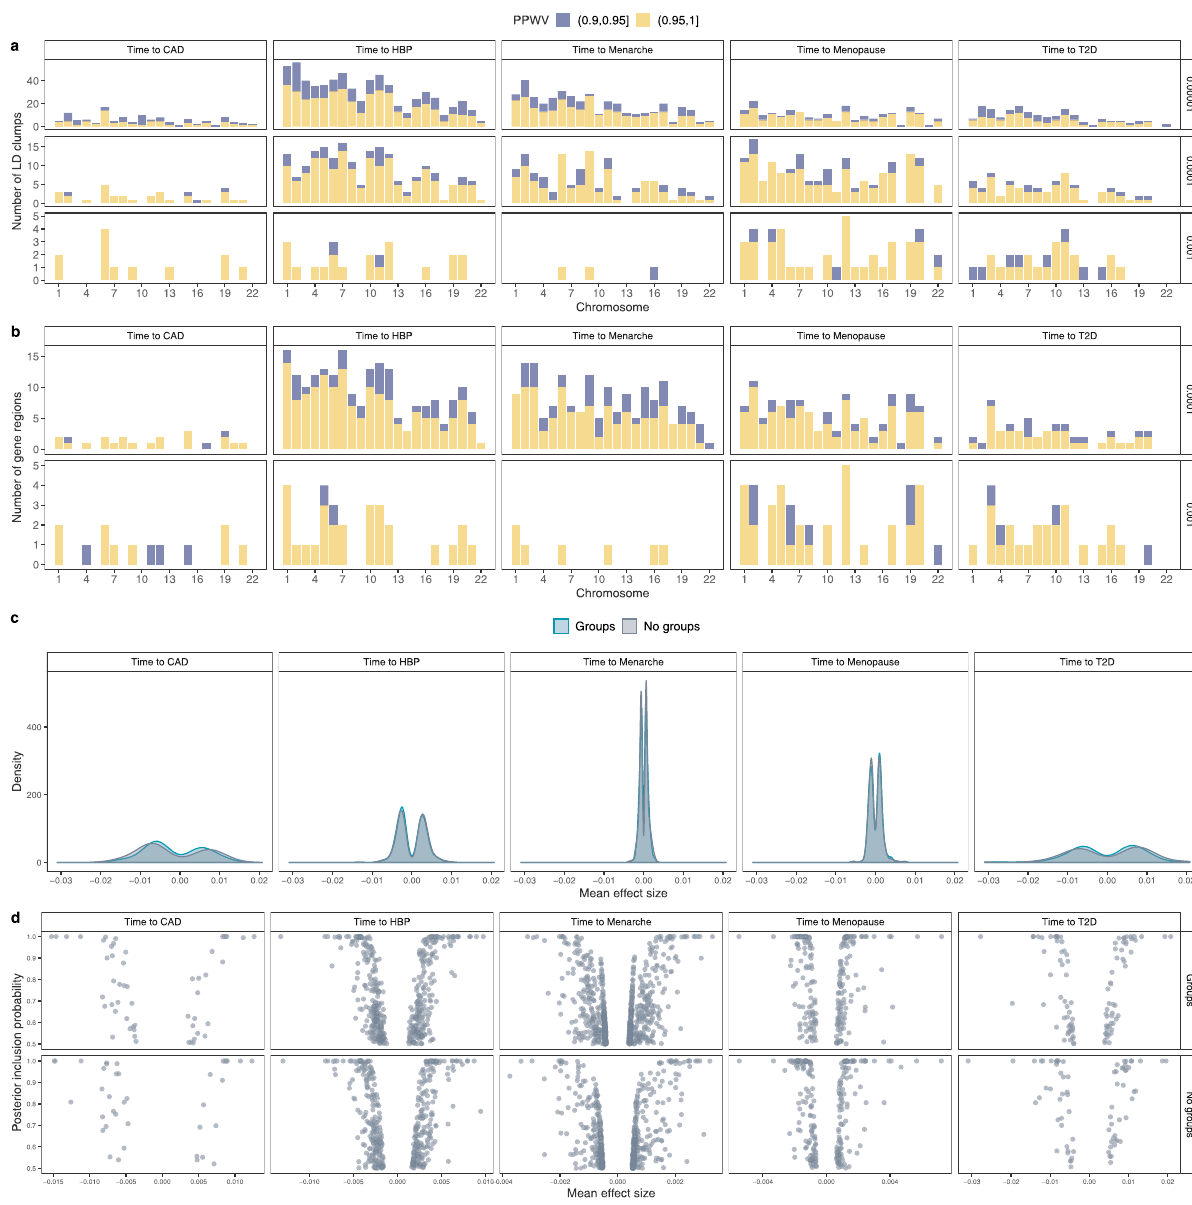
Fig. 3 Regional and individual SNP contributions to the time-to-diagnosis of CAD, HBP, T2D and age-at-menarche and age-at-menopause. a Count of LD clumped regions with high PPWV (Posterior Probability Window Variance). We split the genome into LD clumped regions such that the r 2 < 0.1 between index SNPs. Then we calculated the probability that a region is explaining at least either 0.001%, 0.01% or 0.1% of the genetic variance (PPWV); ( b ) Count of gene-mapped regions with high PPWV. Each marker is mapped to the closest gene given that it is within ±50 kb from the marker, then for each of those gene-speci fi c regions, we calculate PPWV that the region explains either 0.01% or 0.1% of the genetic variance. Both a and b are using the groups model; ( c ) distribution of mean non-zero effect sizes for markers with PIP > 0.5 for models with and without groups, we pick up most large effects for traits such as time-to-diagnosis of CAD or T2D whereas we fi nd an abundance of small effects for age-at-menarche, we see a very small effect of penalisation in the case of group model; ( d ) relationship between mean non-zero effect size and posterior inclusion probability for markers with PIP > 0.5 with markers. Source data are provided as a Source Data fi